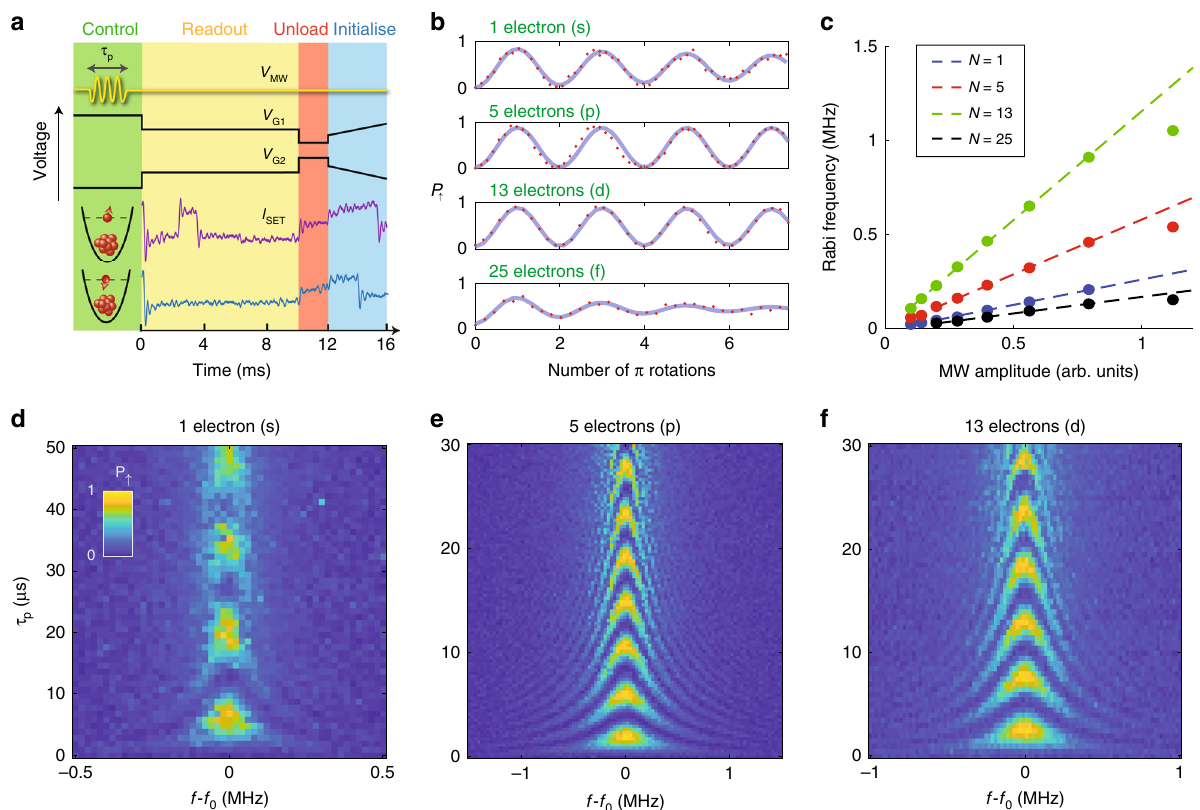
Fig. 2 Coherent spin control. a Gate and microwave pulse sequence for single-qubit control and read-out. The lower section shows the change in SET current when a valence electron is in either a spin up or down state. b Rabi oscillation of the probability of measuring a spin up P ↑ for N = 1, 5, 13 and 25 electrons, under the same driving power from the microwave source. Traces for s, p, d electrons are extracted from ( d – f ) at f = f 0 , fi tted using ¼ A cos ð 2 π f t Þ e (cid:3) t = T Rabi 2 þ c , where A and c are related to the measurement visibility. Horizontal axis is number of π rotations ( τ p P " Rabi c Rabi frequencies as a function of applied microwave power, at different electron numbers N . d – f Probability of spin up as a function of ESR frequency detuning and duration of microwave pulse for ( d ) N = 1, ( e ) N = 5 and ( f ) N = 13 electrons, performed along the grey dashed line in Fig. 3e, f, h, i, k, l, which correspond to the highest Q-factor operating points for each electron occupancy. Resonance frequencies f 0 for N = 1, 5 and 13 are 41.829, 41.879 and 41.827GHz,